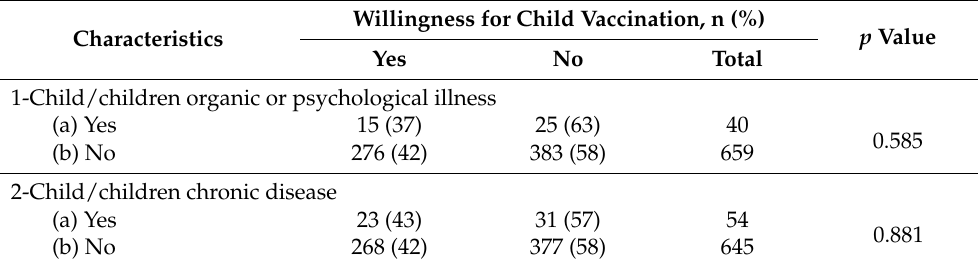
Table 7. Comparison of willingness for child vaccination with child health